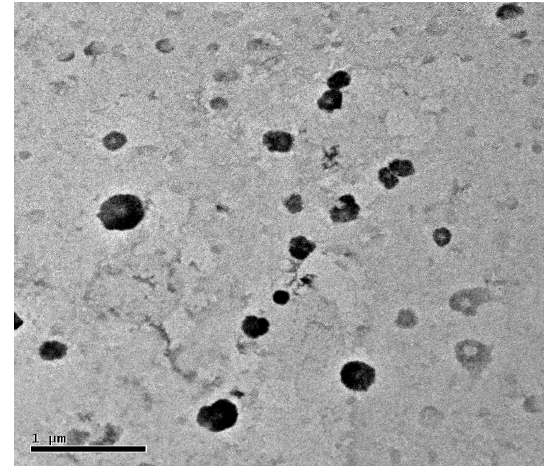
Figure 8. TEM of CHP − 6.03 nanoparticles loading mitoxantrone.